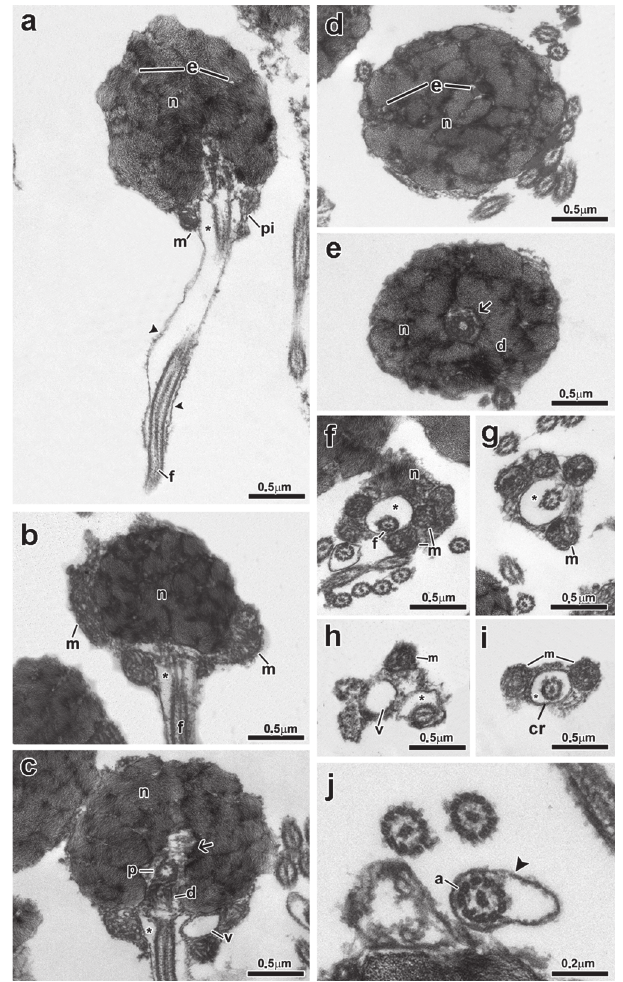
Fig. 6. Spermatozoon of Brycinus lateralis . a, b, c: longitudinal sections. d, e, f, g, h, i, j: transverse sections from top to posterior region. The nucleus (n) is spherical and lies medial to the flagellum (f). The centriolar complex (p, d) and nuclear fossa (arrow) is medial. The proximal centriole (p) is in a right angle relative to the distal centriole (d). The cytoplasmic canal is present (asterisk). The midpiece (pi) is asymmetrical, and contains the spherical mitochondria (m), vesicles (v) and a cytoplasmic sleeve (arrowhead). Legends: a: axoneme, cr: concentric membranous rings, d: distal centriole, e: electron- lucent areas, f: flagellum, m: mitochondria, n: nucleus, p: proximal centriole, v: vesicle, asterisk: cytoplasmic canal, arrow: nuclear fossa, arrowhead: cytoplasmic sleeve.